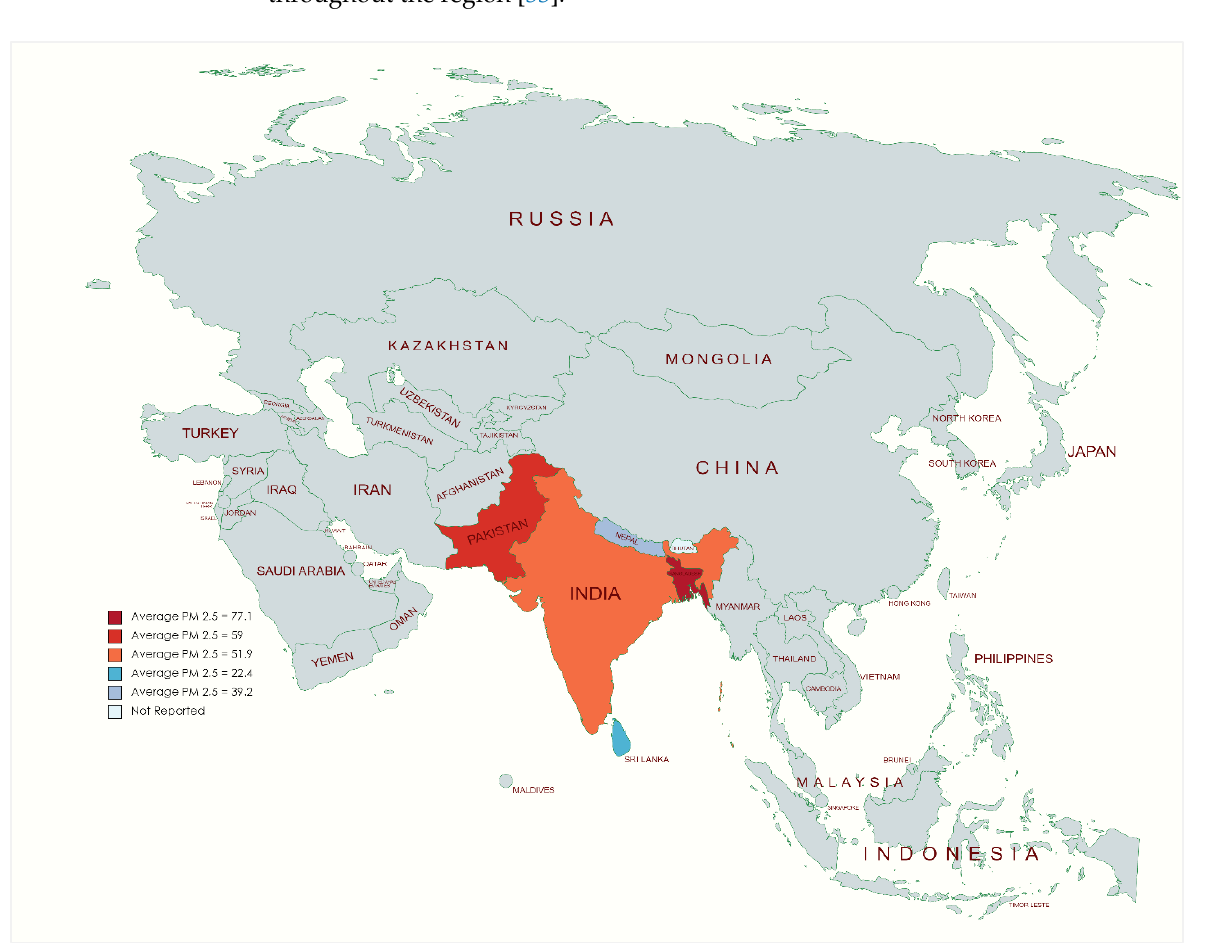
µ g/m 3 ) yearly average visual 2.5 (in